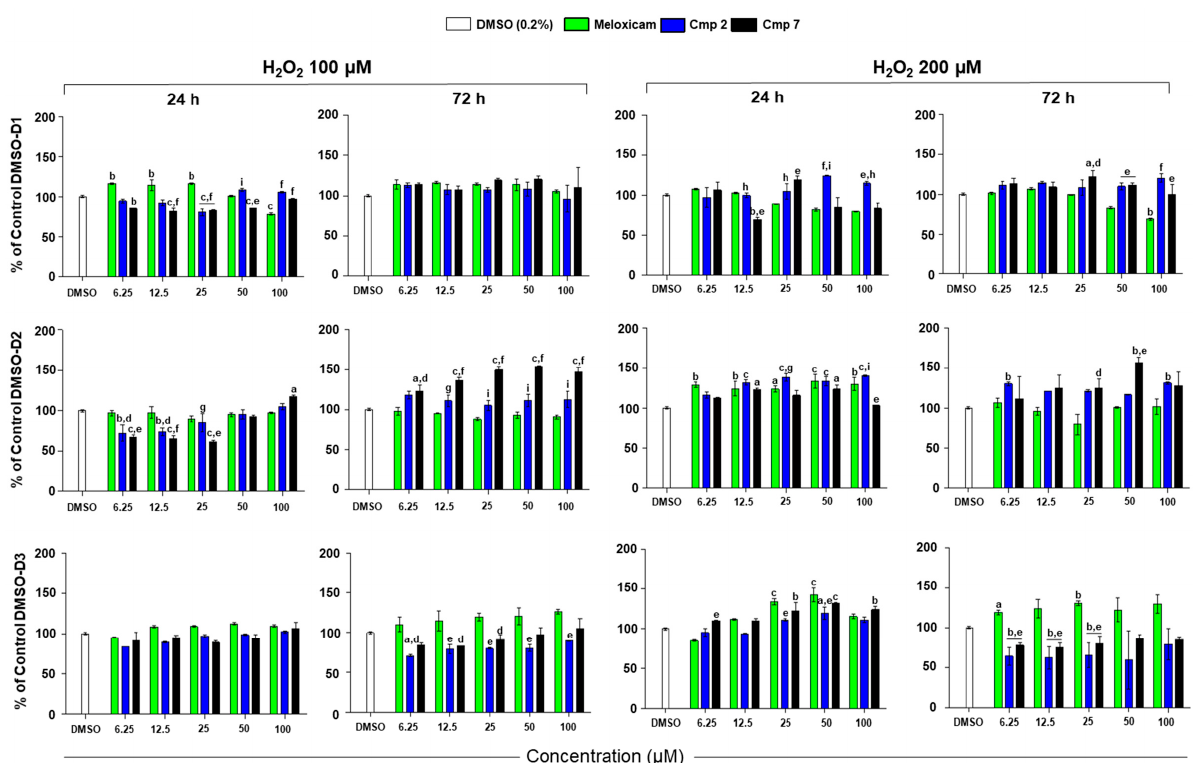
Figure 2. Metabolic activity of tendon-derived cells pre-incubated with hydrogen peroxide (H 2 O 2 ) in the presence of Meloxicam and Cmp 2 and Cmp 7 . Data are reported as means ± standard deviations of independent experiments with the three donors separately (n = 9). D1 = donor 1; D2 = donor 2; D3 = donor 3. Bar graphs show the percentages of cell metabolic activity of tenocytes pre-incubated with H 2 O 2 100 ( A ) and 200 µ M ( B ) for 3 h and afterwards exposed to loading concentrations of Meloxicam, Cmp 2 , and Cmp 7 for 24 and 72 h. Cells treated with DMSO alone (vehicle) were set as control (100% of cell metabolic activity). DMSO = cultures pre-incubated with H 2 O 2 and treated with dimethyl sulfoxide (DMSO) 0.2%. a = p < 0.01; b = p < 0.001; c = p < 0.0001 between samples and DMSO alone; d = p < 0.01; e = p < 0.001; f = p < 0.0001 between samples and Meloxicam at the same concentration; g = p < 0.01; h = p < 0.001; i = p < 0.0001 between Cmp 2 and Cmp 7 at the same